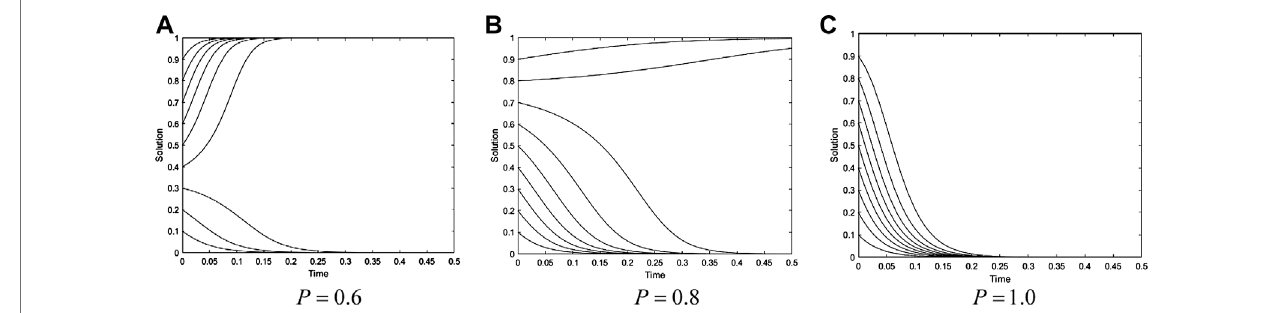
FIGURE 3 | Dynamic phase diagram of the evolutionary game under different P values. (A) P = 0.6, (B) P = 0.8, and (C) P = 1.0.